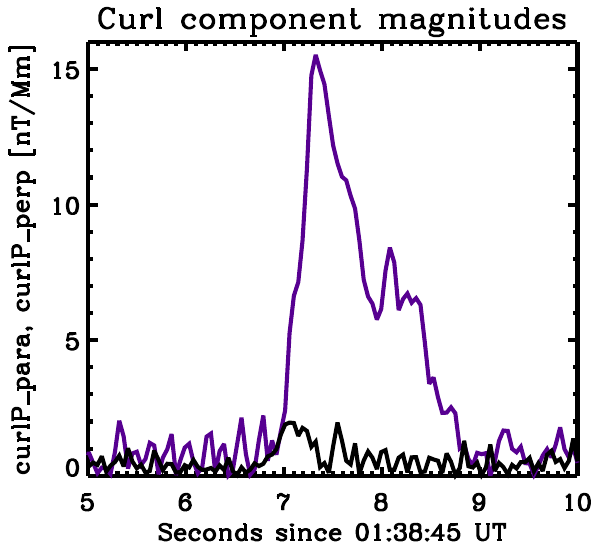
Fig. 8. Components of the curl estimator − m × ˙ P derived from four- point crossing time analysis: parallel (magenta) and perpendicular (black) to the (local) magnetic field